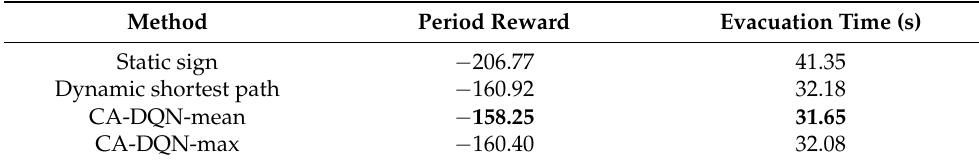
Table 1. Comparison of evacuation times using different methods.